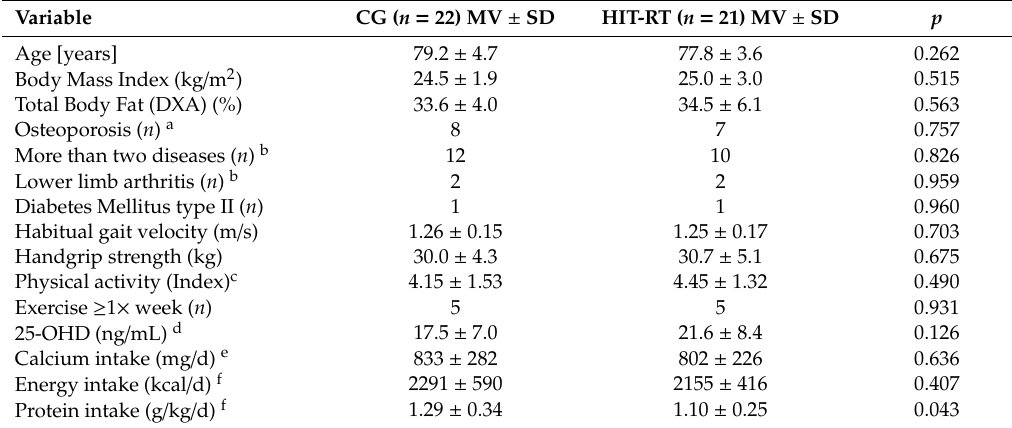
Table 1. Baseline characteristics of the participants of high intensity resistance exercise training group (HIT-RT) versus the control groups (CG). MV ± SD: mean value ± standard